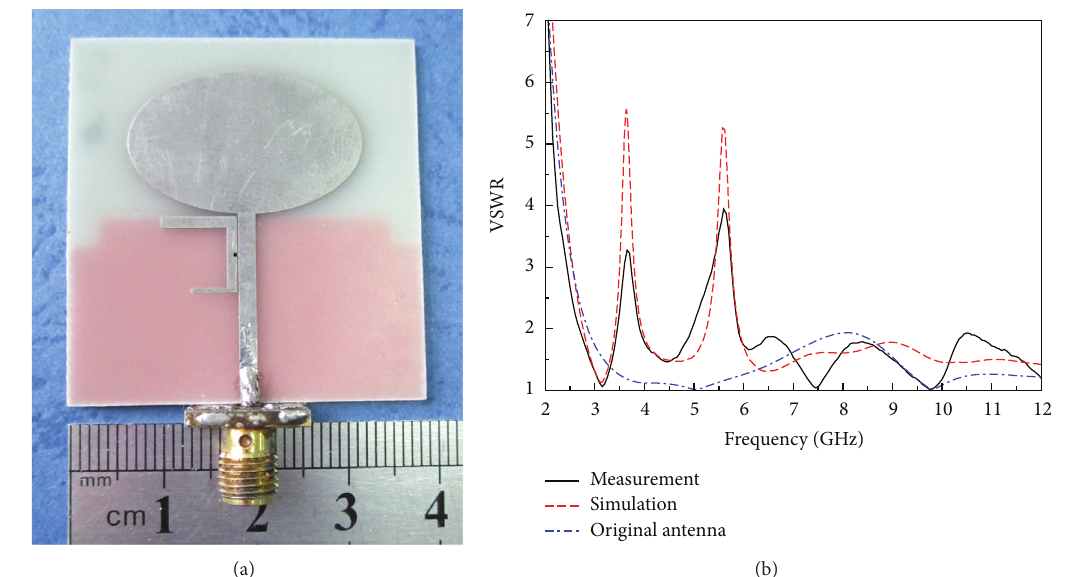
Figure 8: (a) Photograph of prototyped antenna. (b) Simulated and measured VSWR of the proposed antenna.